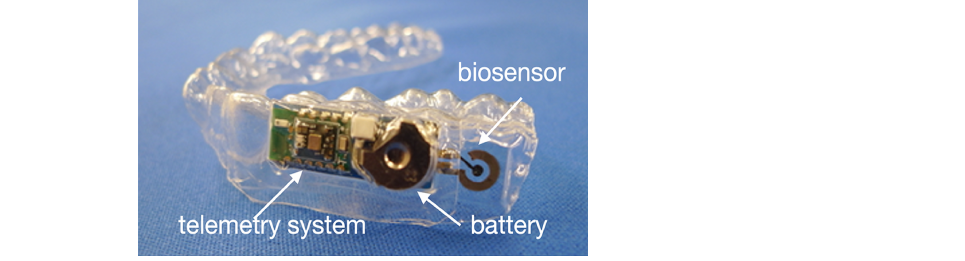
Tears also carry information and show similar glucose concentration to blood